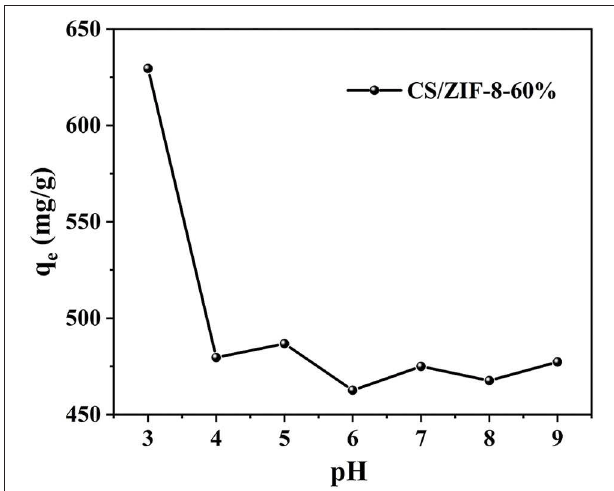
FIGURE 4 | Effect of pH on U(VI) adsorption of CS/ZIF-8–60% composite beads ( C 0 = 100 mg • L − 1 , t = 24h, m ads / V sol = 0.2 g • L − 1 ).